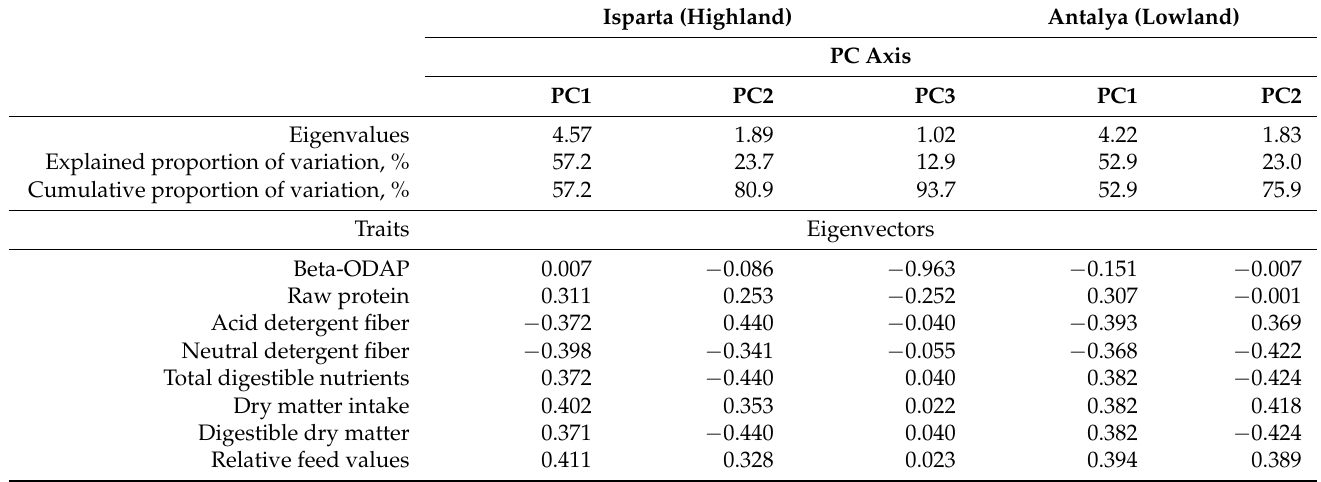
Table 4. Eigenvectors for principal components (PCs) of traits associated with forage and quality value of 94 grass pea genotypes produced in two different